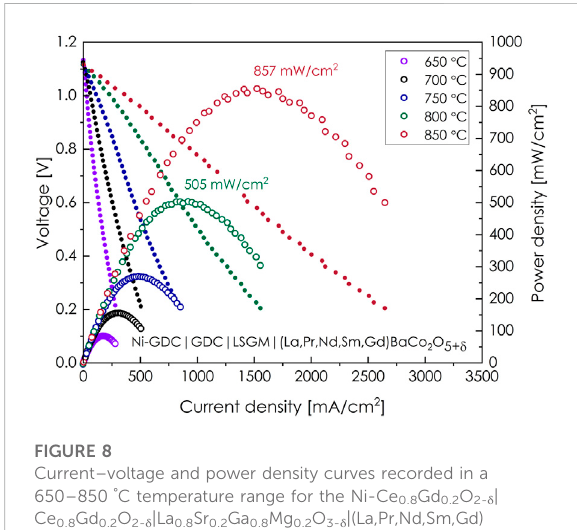
FIGURE 6 Impedance spectra collected during electrode polarization resistance measurements of (La,Pr,Nd,Sm,Gd)BaCo 2 O 5+ δ layers (manufactured on an LSGM solid electrolyte), performed with the use of the EIS method. The applied equivalent circuit is also presented. All spectra are corrected by the R 0 value.